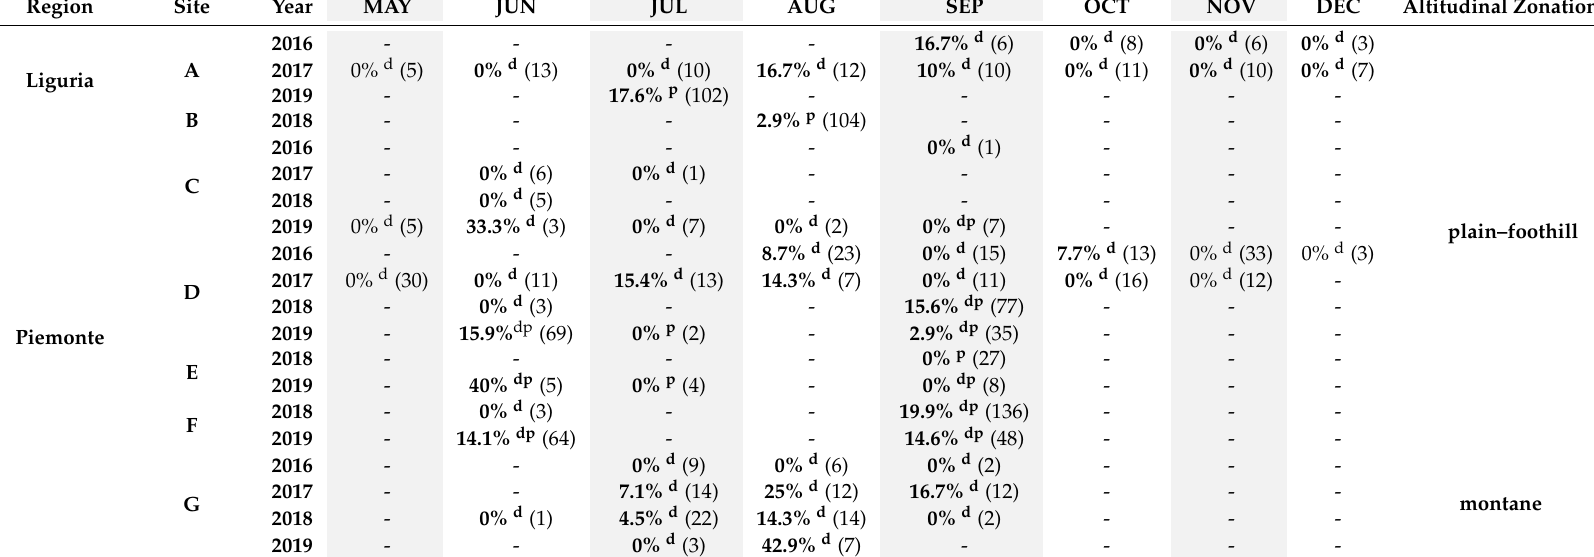
Table 3. Monthly prevalence (%) of Verrallia aucta in the samples of Philaenus spumarius collected in northwestern Italian regions from 2016 to 2019 (sample size in